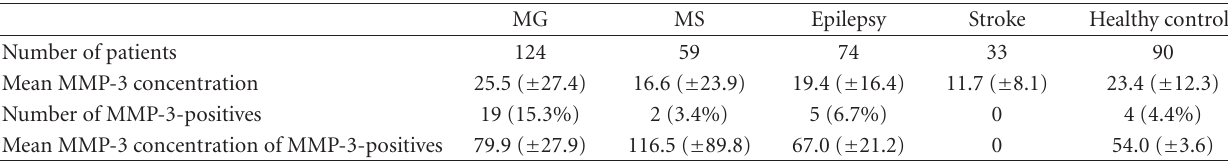
Table 1: MMP-3 concentrations (ng/mL) in patients with neurological disorders and healthy